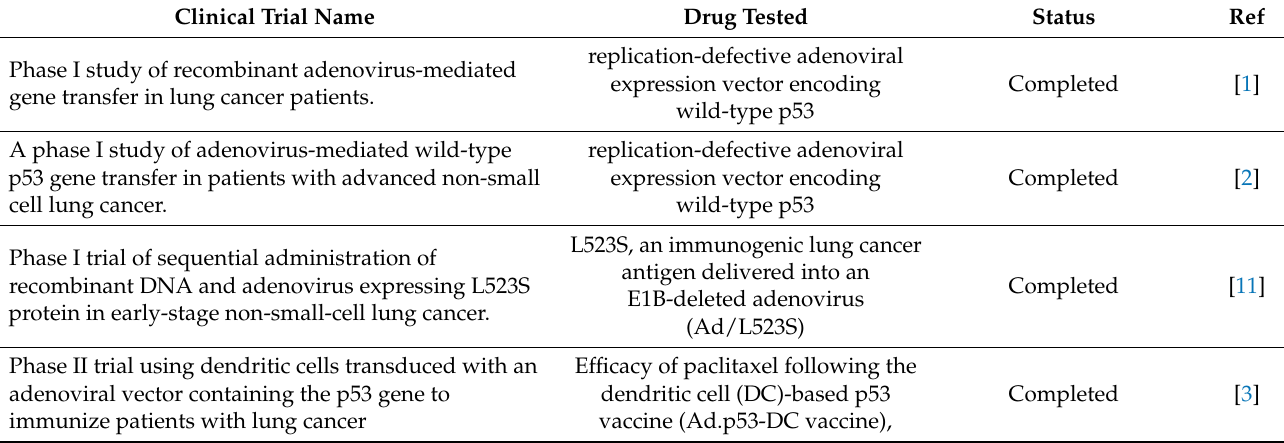
Table 1. Clinical trials using adenovirus-based therapies in lung